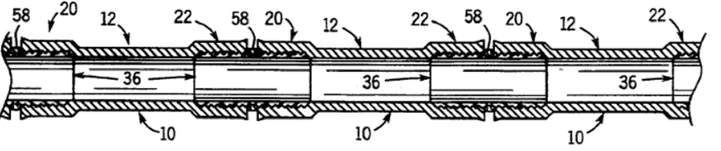
Figure 12. A method of producing composite barrels with internal threads at the ends [51].